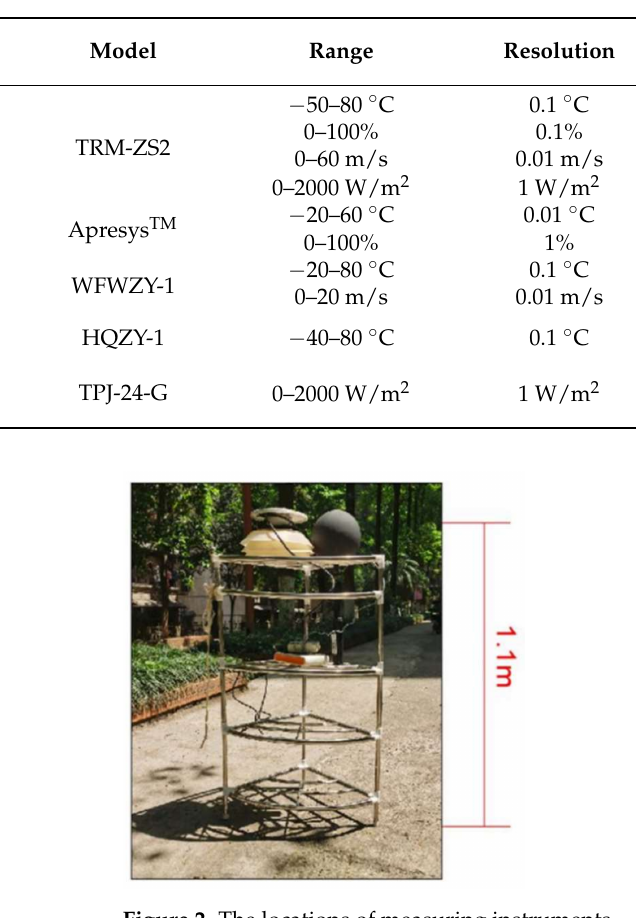
Figure 2. The locations of measuring